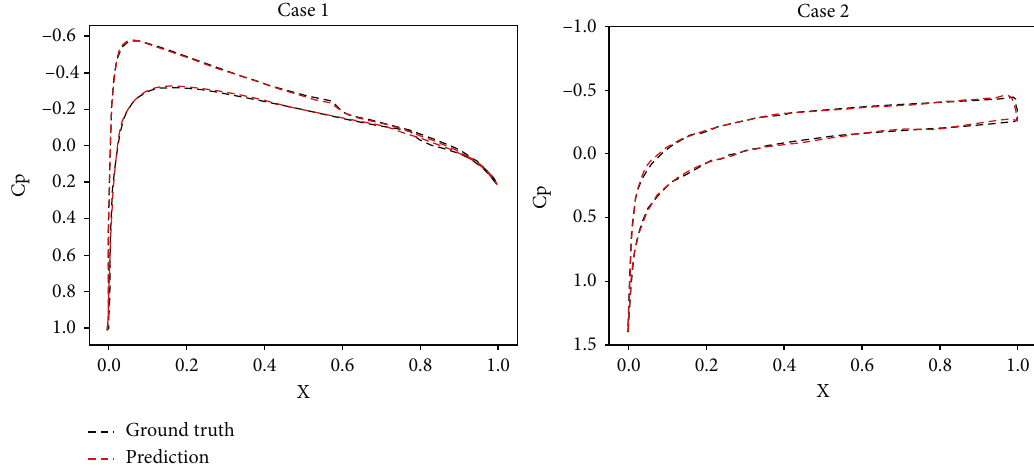
Figure 13: Cp prediction on NACA0012